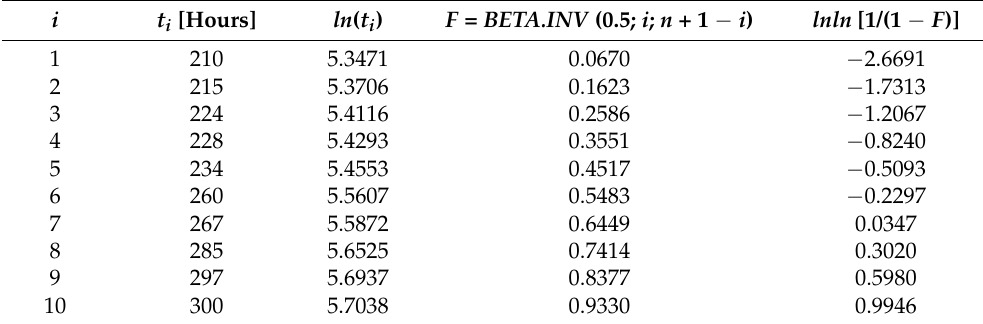
Table 2. Calculated values for estimating and linear regression of the distribution function F ( t ) for γ = 0.